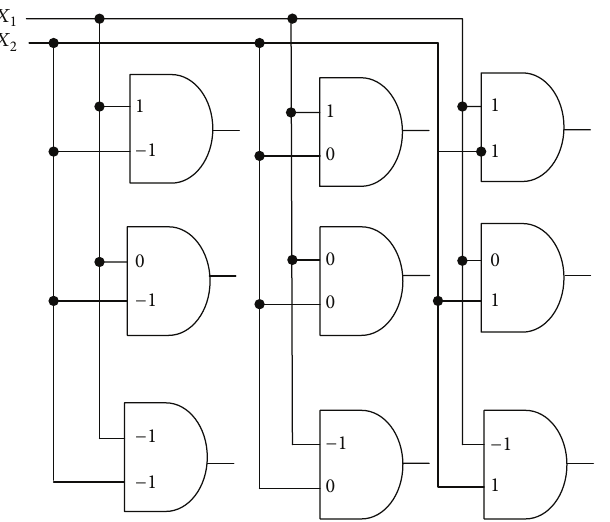
Figure 2: Clustering data in the KOHONEN neural network algorithm.